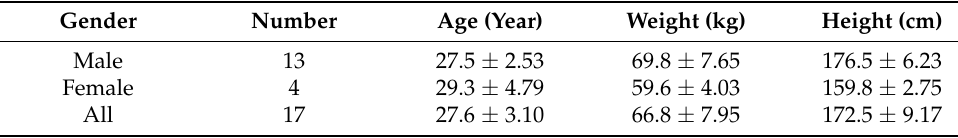
Table 3. The participant characteristics (Mean ±